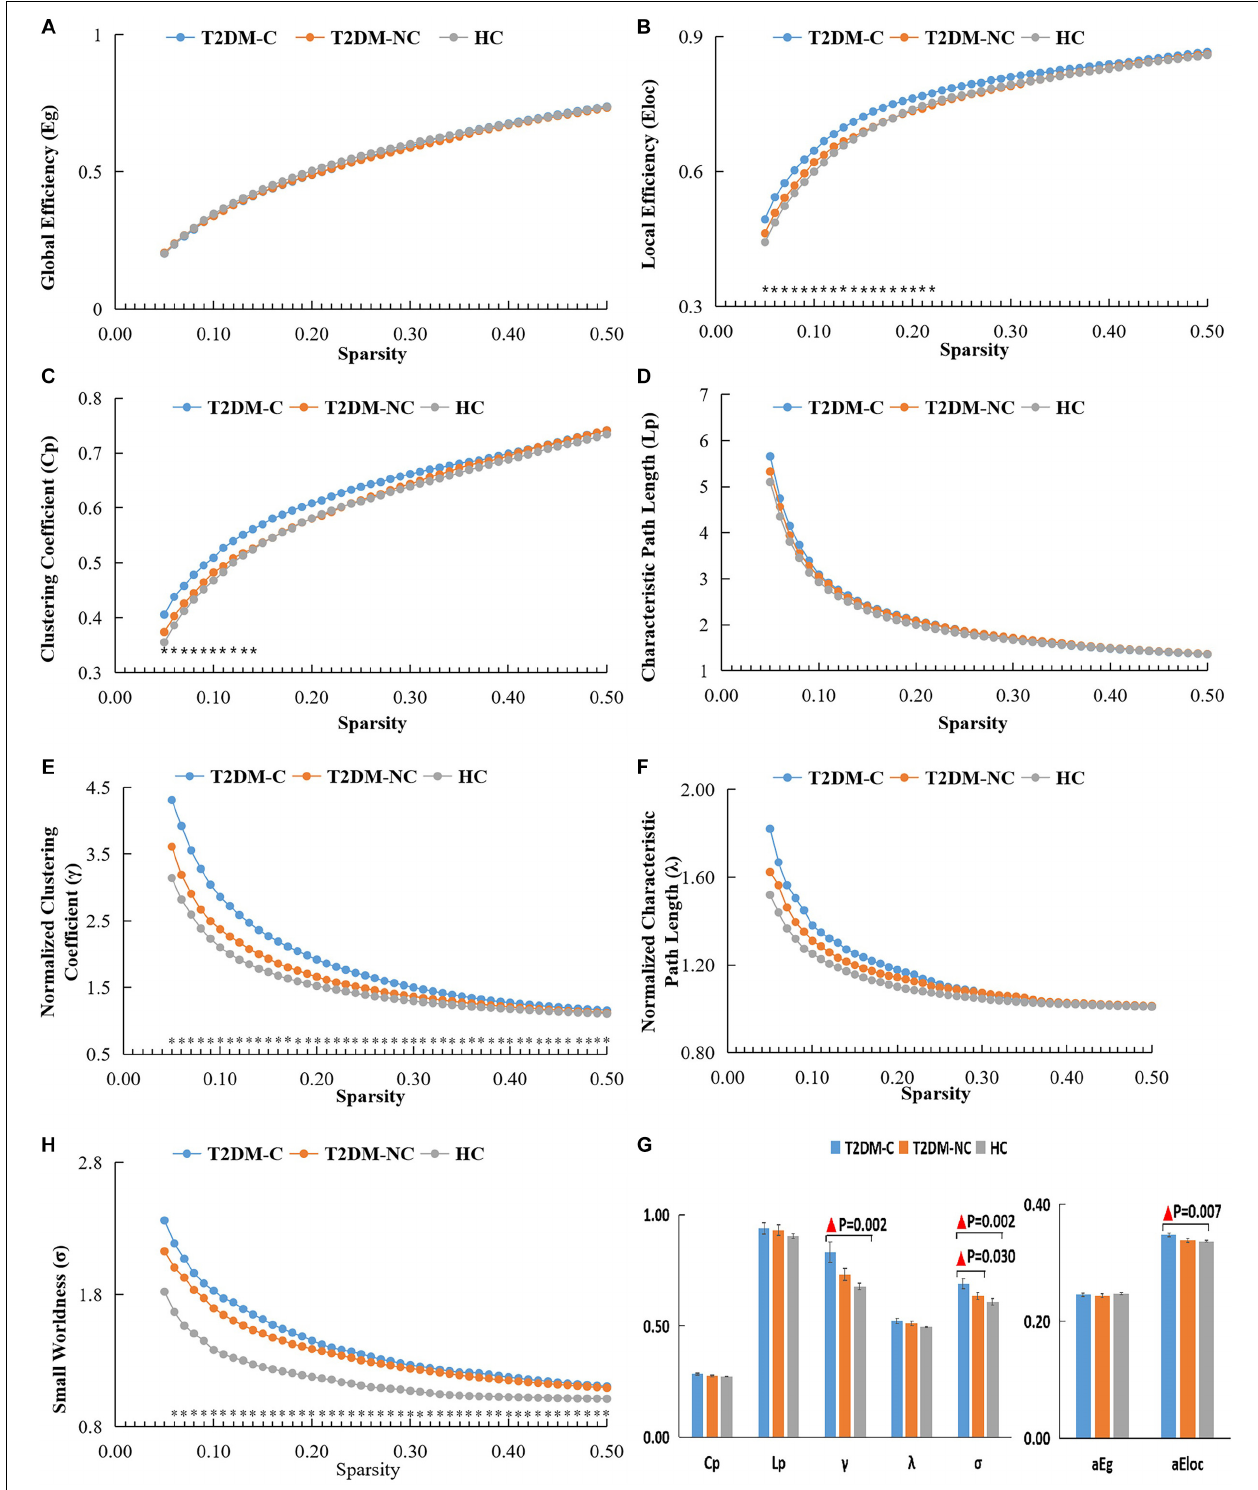
FIGURE 1 | The global topological metrics of the whole-brain functional network of the three groups. Graphs (A–G) show the small-word properties and network efficiency under different sparsity (0.05 < S < 0.5). The AUC of small-world properties and network efficiency over full sparsity range is shown by histogram graphs (H) . The symbol “ (cid:78) ” denotes statistical significance. Cp, clustering coefficient; Lp, characteristic path length; γ , normalized clustering coefficient; λ , normalized shortest path length; Eg, global efficiency; Eloc, local efficiency; AUC, area under curve.